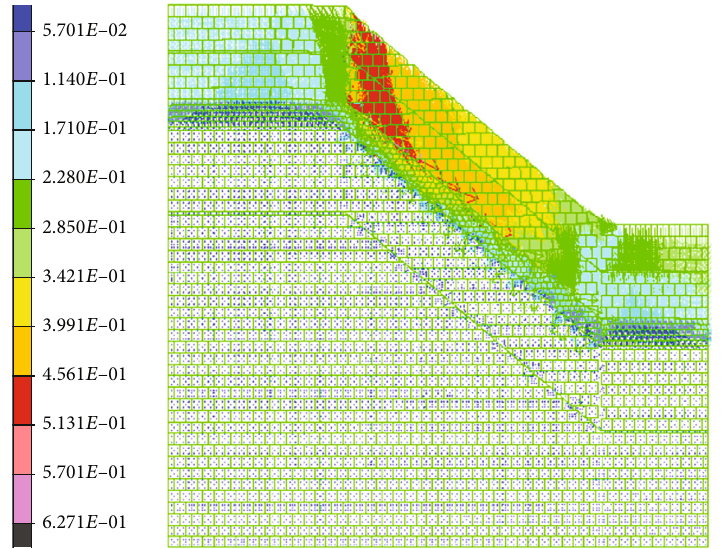
Figure 13: Displacement vector diagram when running 80,000 steps.